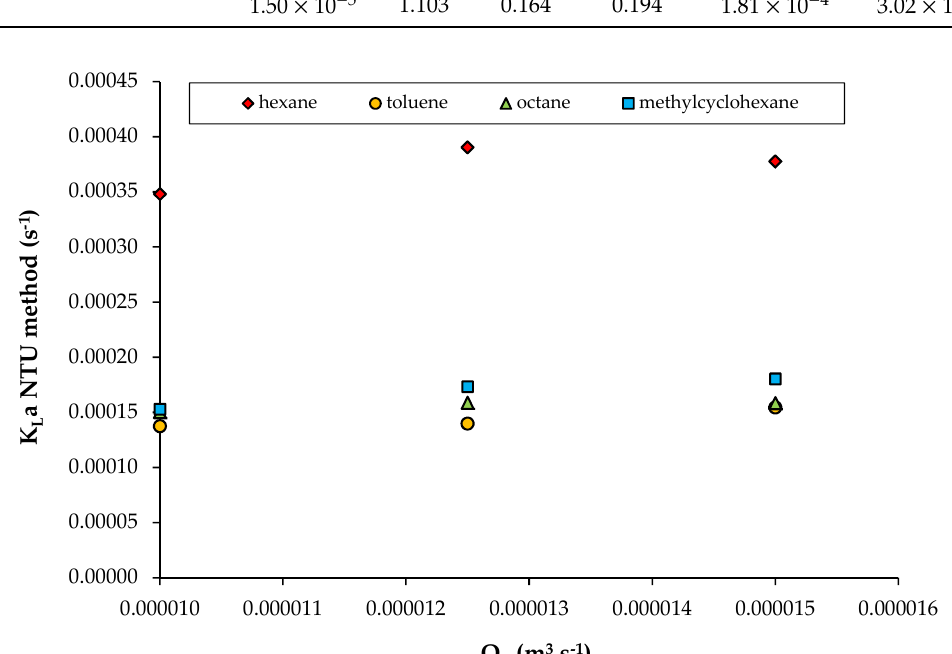
Figure 6. K L a versus liquid flow-rate (from the data analysis reported in Reference [6]).